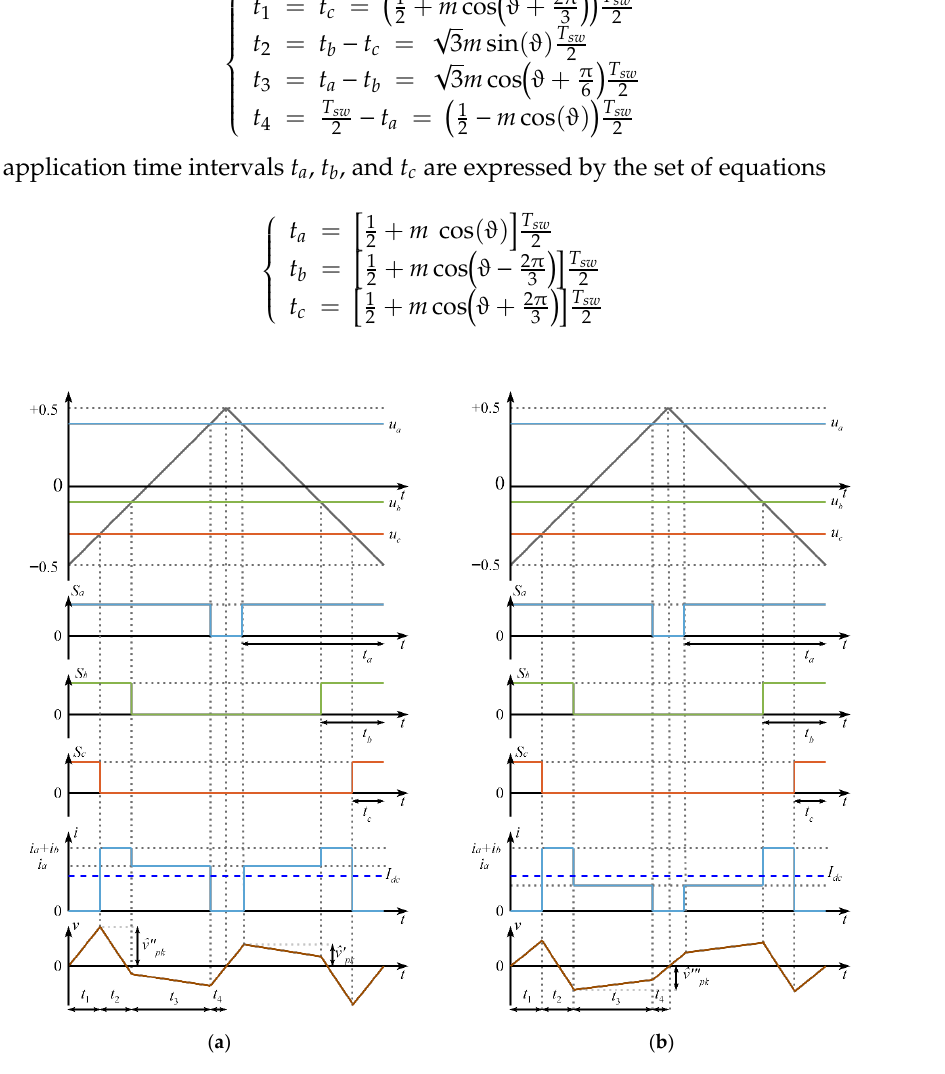
Figure 5. Input current and dc-link voltage ripple in one switching period in case of balanced